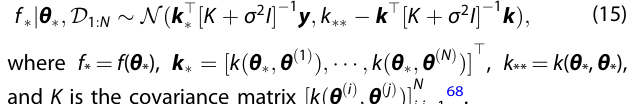
Algorithm 1 Stochastic gradient line Bayesian optimization (SGLBO)